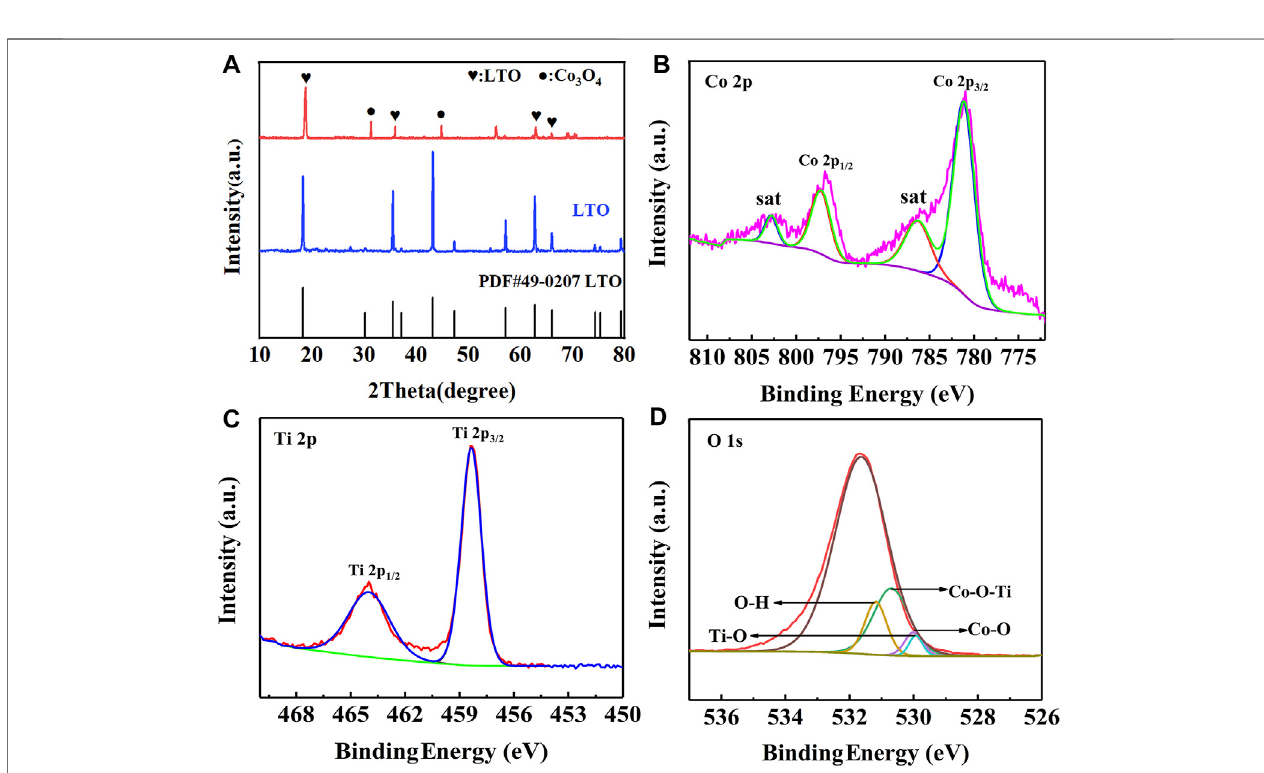
FIGURE 2 | (A) XRD patterns of Li 4 Ti 5 O 12 and Li 4 Ti 5 O 12 /Co 3 O 4 composite. (B – D) XPS patterns of Li 4 Ti 5 O 12 /Co 3 O 4 composite. (B) Co 2p; (C) Ti 2p; (D) O 1s.